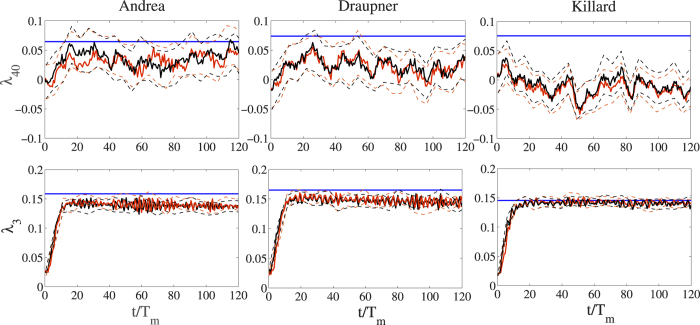
Time evolution of skewness λ3 and excess kurtosis λ40 for (left) Andrea, (center) Draupner and (right) Killard sea states; HOS second-order (black solid), HOS third-order (red solid) averages and theoretical predictions of the narrowband Tayfun skewness and Janssen excess bound kurtosis (blue solid, see Eq. (9) n Methods Section).95% confidence bands (dashed) are also shown. Time is normalized by the mean wave period Tm. The statistical parameters are estimated from an ensemble of 50 HOS simulations. The initial artificial transients are excluded from the ensemble averages as they are the result of a ramping function55 applied to the HOS equations to smoothly activate nonlinearities. See Methods section for details and definitions of wave parameters.